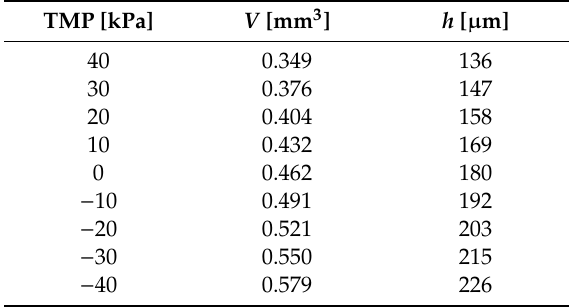
Table A1. Channel fluid volume and equivalent height as a function of TMP.